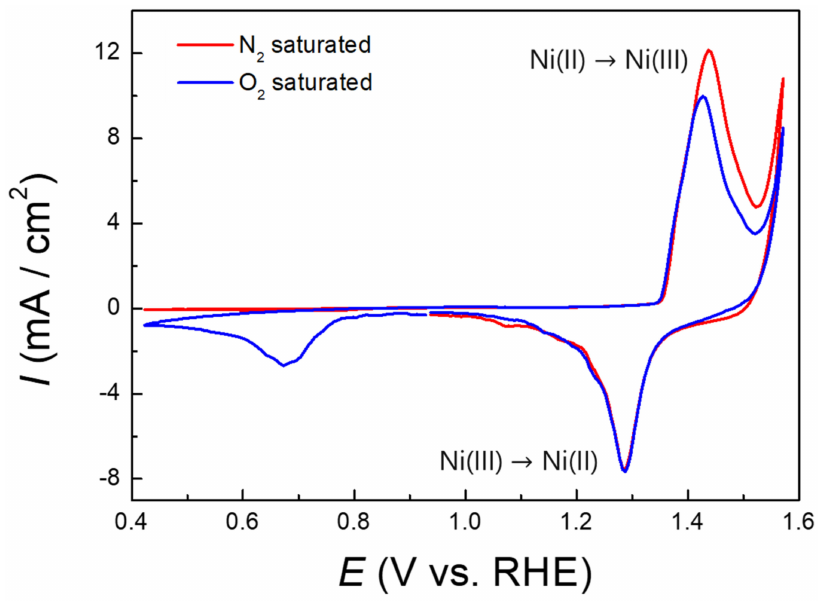
Figure 1. Cyclic voltammograms of Ni(dto)-DH/C electrode recorded at a scan rate of 5 mV/s in nitrogen- or oxygen-saturated 1 M KOH